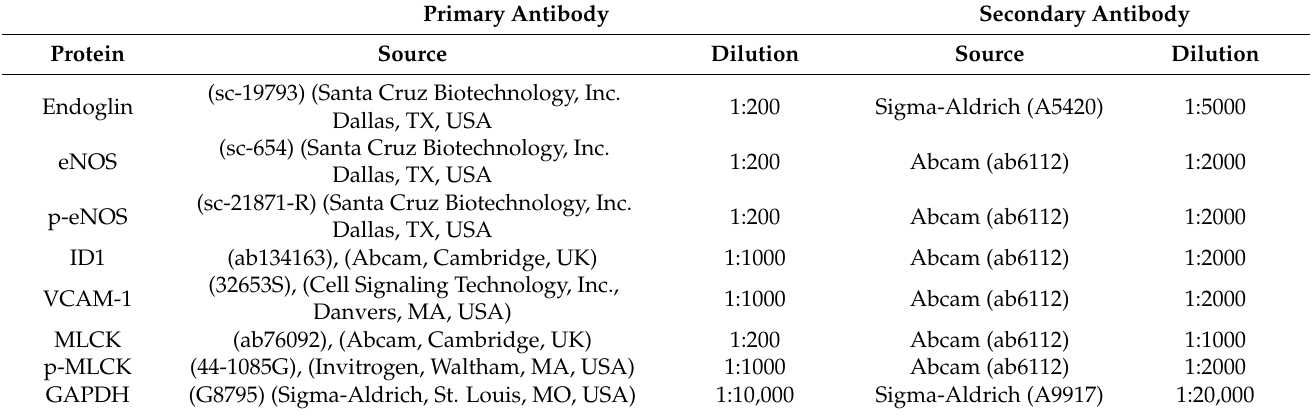
Table 1. List of primary and secondary antibodies used for Western blot